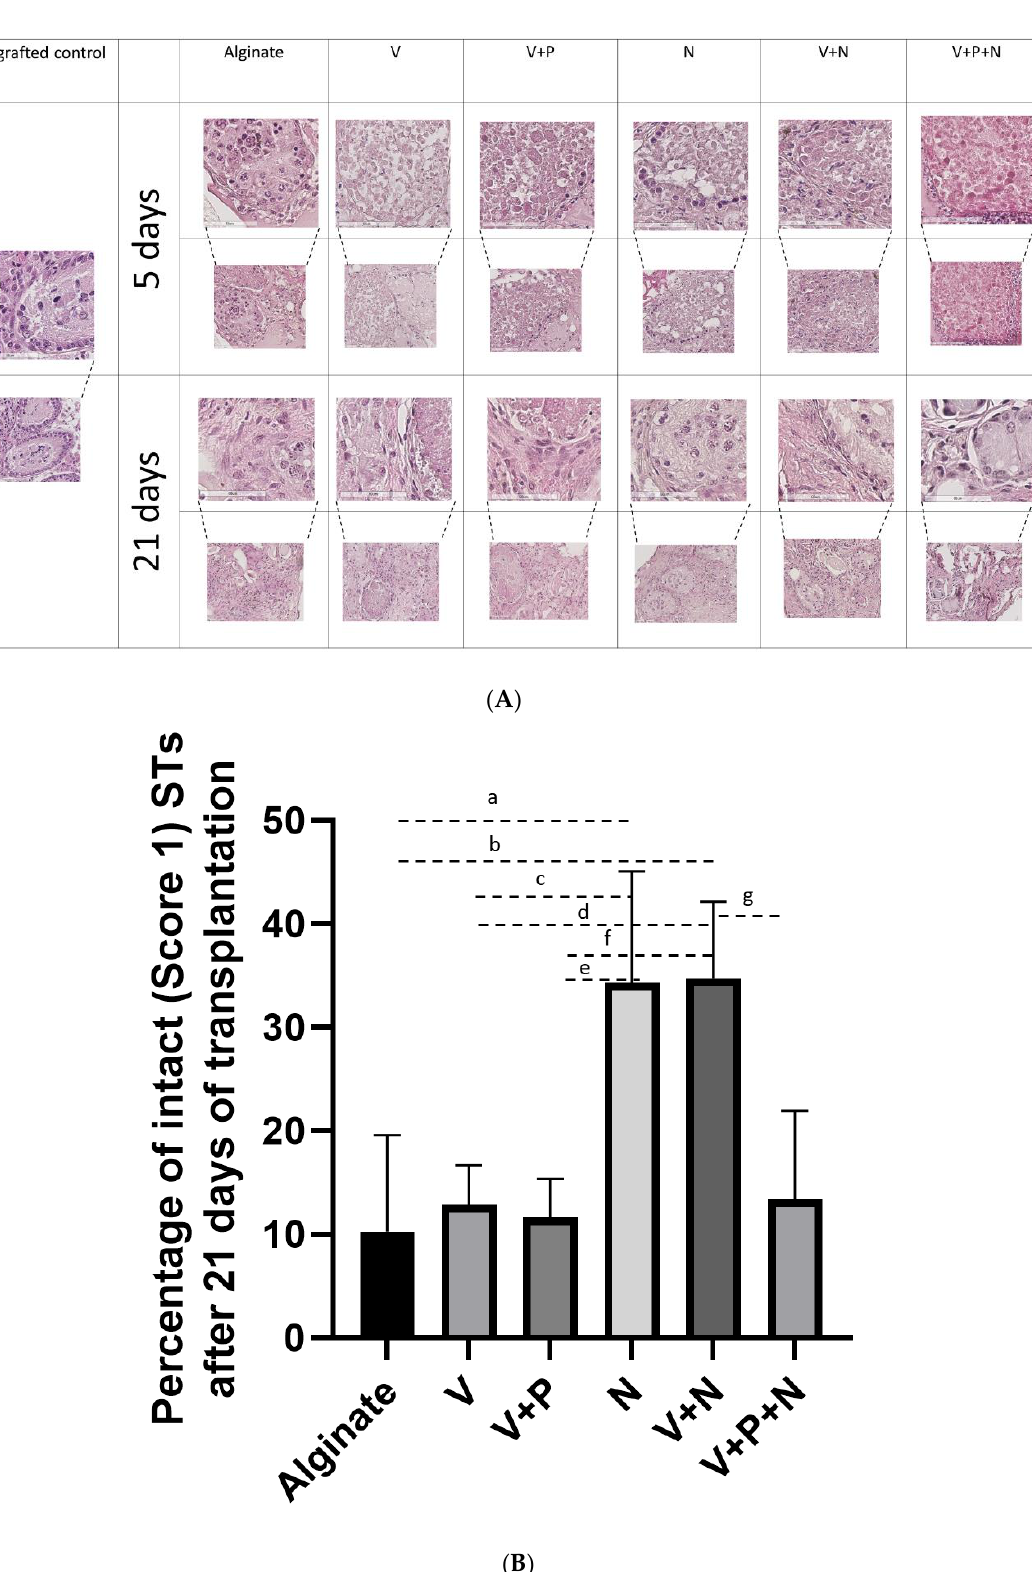
Figure 2. Impact of NP supplementation on seminiferous tubule integrity. Mouse testicular tissues were encapsulated in alginate supplemented with five different combinations in addition to a negative control (Alginate, V, V+P, N, V+N and V+P+N) for 21 days. Seminiferous tubule integrity was ( A ) visualized by hematoxylin–eosin-staining 5 and 21 days after orthotopic auto-transplantation and ( B ) quantified after 21 days. Results are expressed as the mean percentage of intact (Score 1) STs ± standard deviation. a: p = 0.02; b: p = 0.02; c: p = 0.04; d: p = 0.04; e: p = 0.03, f: p = 0.03; g: p = 0.04 ( n = 3).